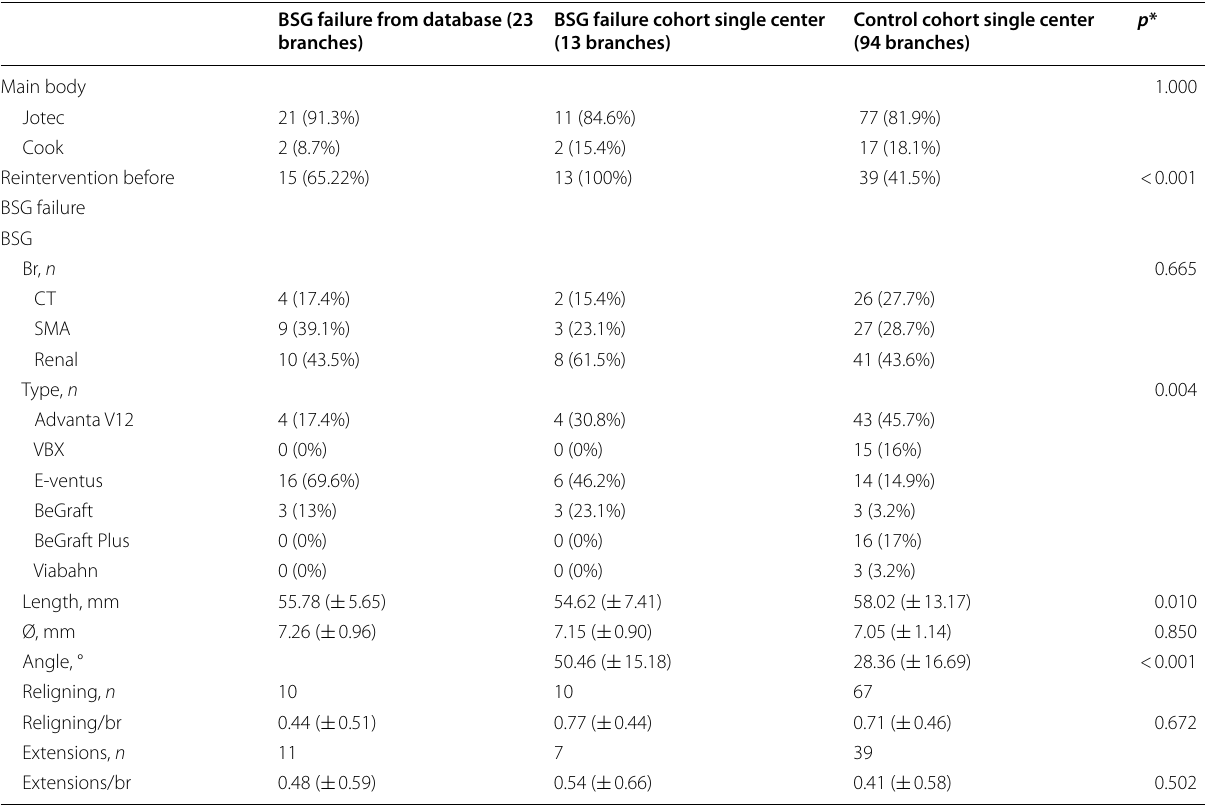
Table 2 Comparison of branch characteristics and used BSG types in general and for each branch